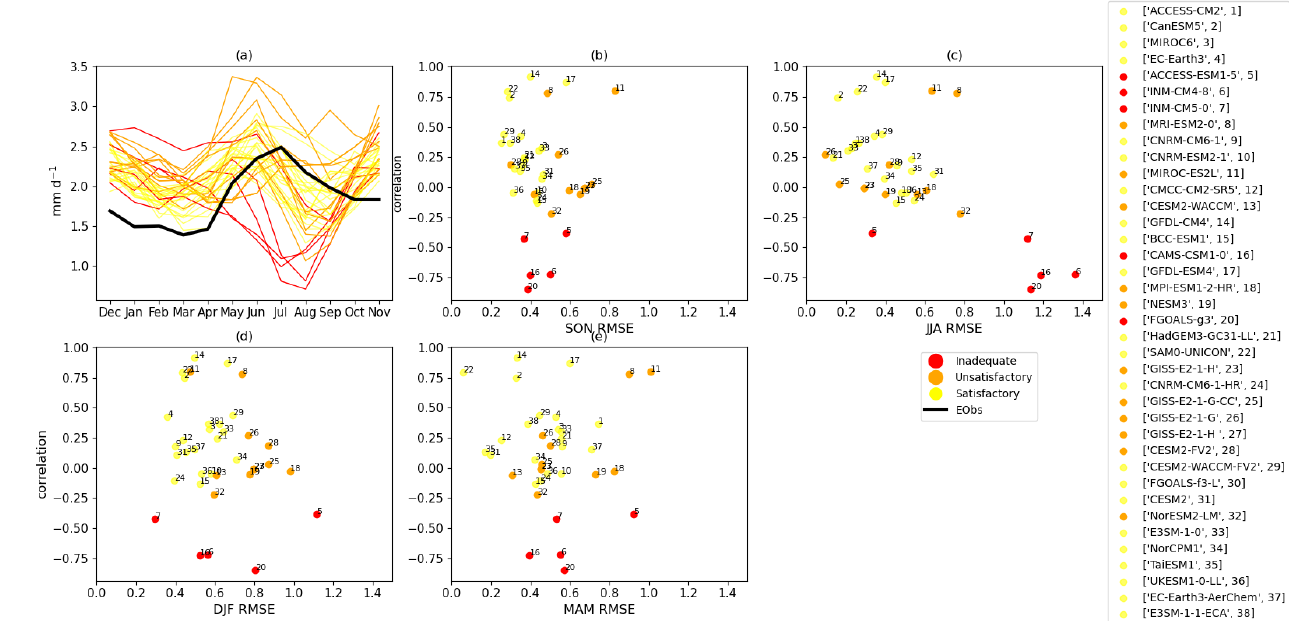
Figure A1. Precipitation annual cycle for CEU (a) ; model comparison with E-OBS (shown as solid black line). Correlation (over 12 months) and seasonal RMSEs for each model. Monthly averages are taken over a 20-year climatology (1995–2014). The RMSEs and correlations are calculated from the monthly averages.